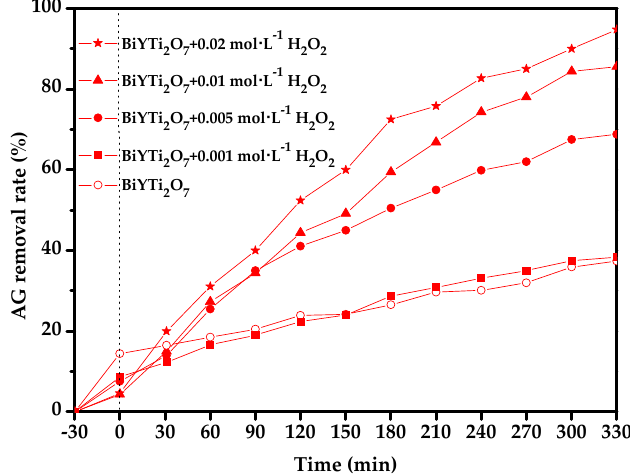
Figure 18. Influence of H 2 O 2 in the degradation of AG with BiYTi 2 O 7 .